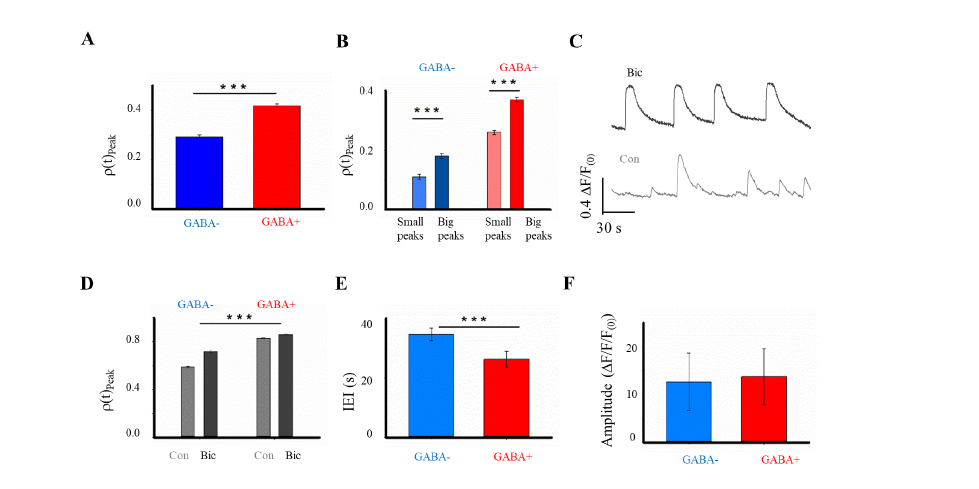
Fig. 6. Calcium transients from dissociated GABA+ and GABA- neurons. (A) Average ρ(t) Peak , computed in 1 s time window, among pairs of GABA+ vs pairs of GABA- neurons in the network (0.420 ± 0.007 vs 0.294 ± 0.007, respectively). (B) Same as (A) distinguishing between small and big peaks (defined by a threshold equal to the 30% of the maximal amplitude observed in each trace: 0.370 ± 0.007 vs 0.181 ± 0.009 for GABA+ neurons; 0.263 ± 0.007 vs 0.110 ± 0.008 for GABA- neurons). n = 605(3) pairs of neurons(sample) for GABA+, n = 870(3) pairs of neurons(sample) for GABA-. (C) Representative ΔF/F (0) traces in control and after application of bicuculline 1 µM. (D) Average ρ(t) Peak in control and after bicuculline application, in GABA+ and GABA- neurons, computed in a time window of 10 s (0.728 ± 0.006 and 0.865 ± 0.003 for GABA+ neurons in control and bicuculline conditions; 0.590 ± 0.007 and 0.828 ± 0.005 for GABA- neurons in control and bicuculline conditions ). (E) Average IEI (s) between peaks of calcium transients in GABA+ and GABA- neurons (26.07 ± 2.13 vs 34.62 ± 2.62). (F) Average amplitude (ΔF/F (0) ) in the two neuronal populations (0.14 ± 0.06 vs 0.13 ± 0.06). n = 73(3) neurons(sample) for GABA+, n = 105(3) neurons(sample) for GABA-). ⃰ ⃰ ⃰ p < 0.001 One-Way